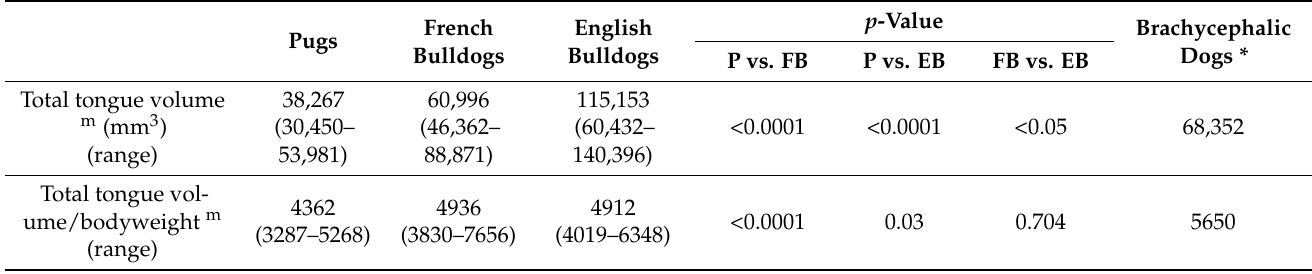
Table 2. Comparison of tongue dimensions between three brachycephalic